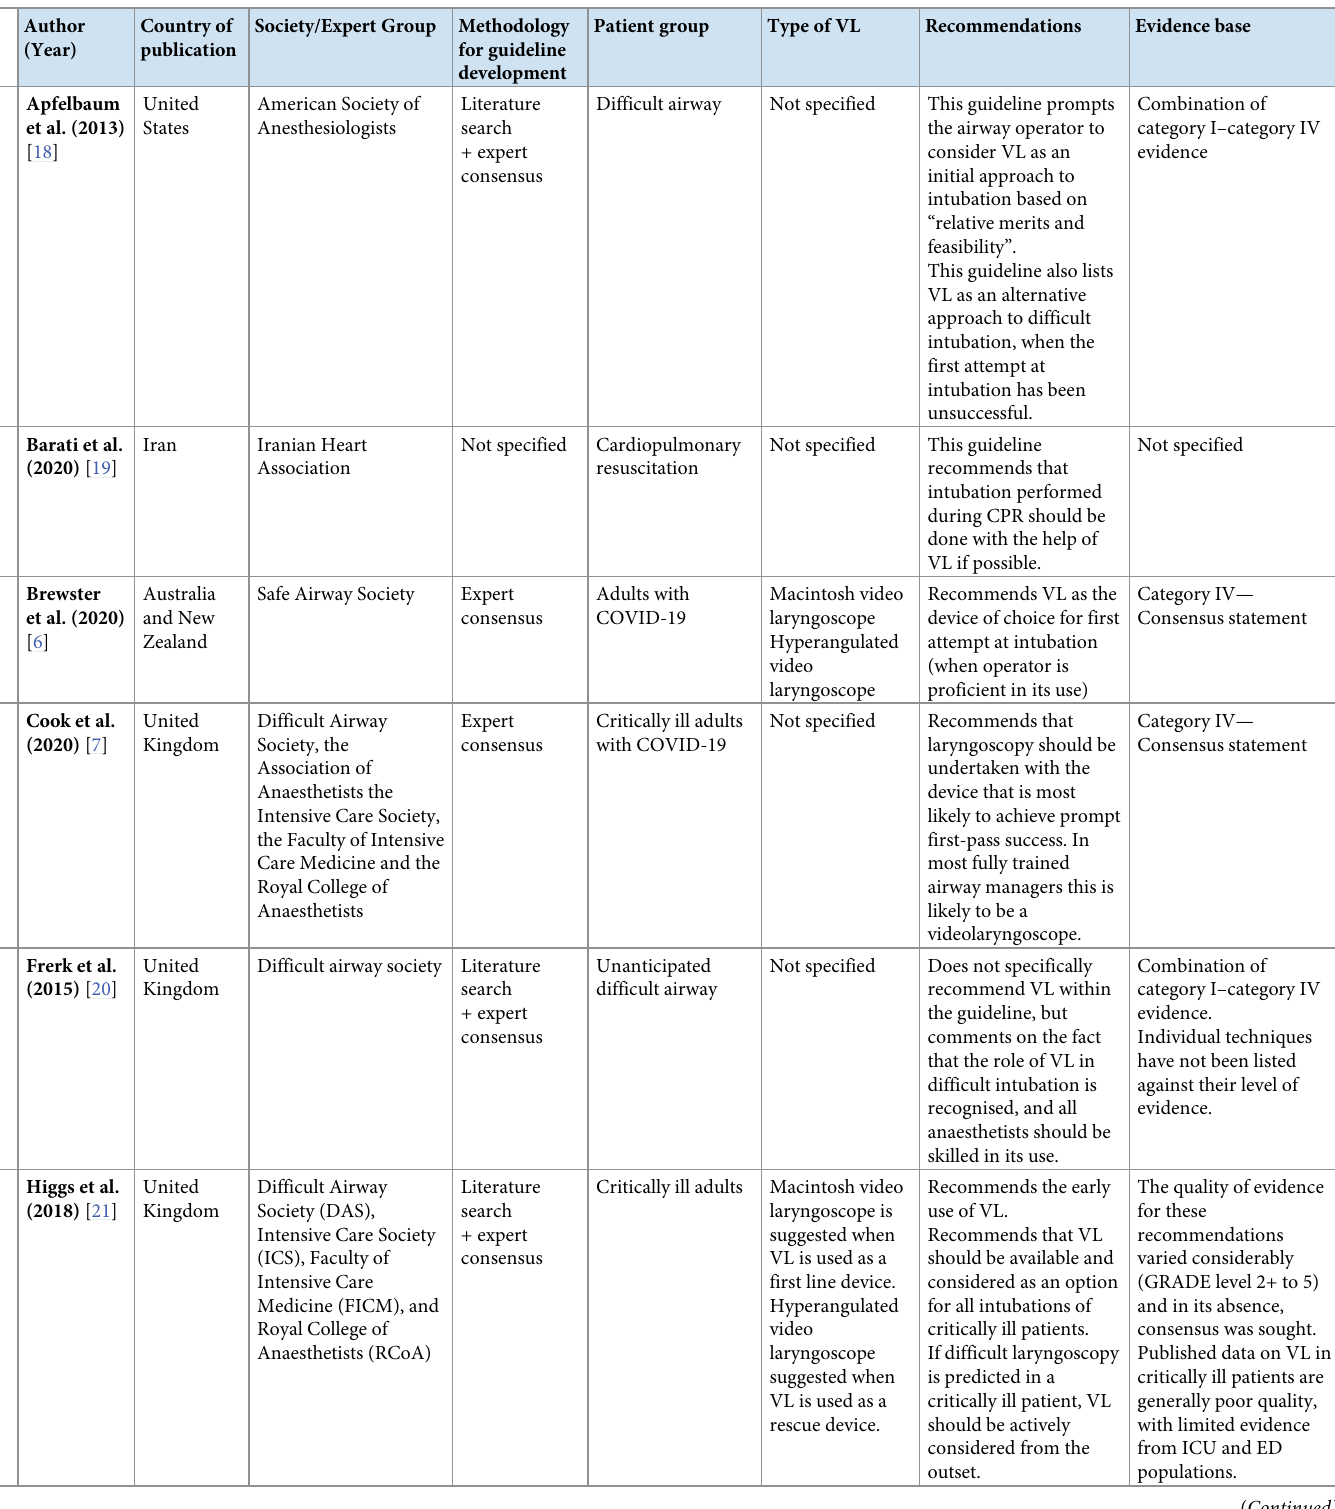
Table 1. Clinical practice guidelines and consensus statements recommending VL outside the